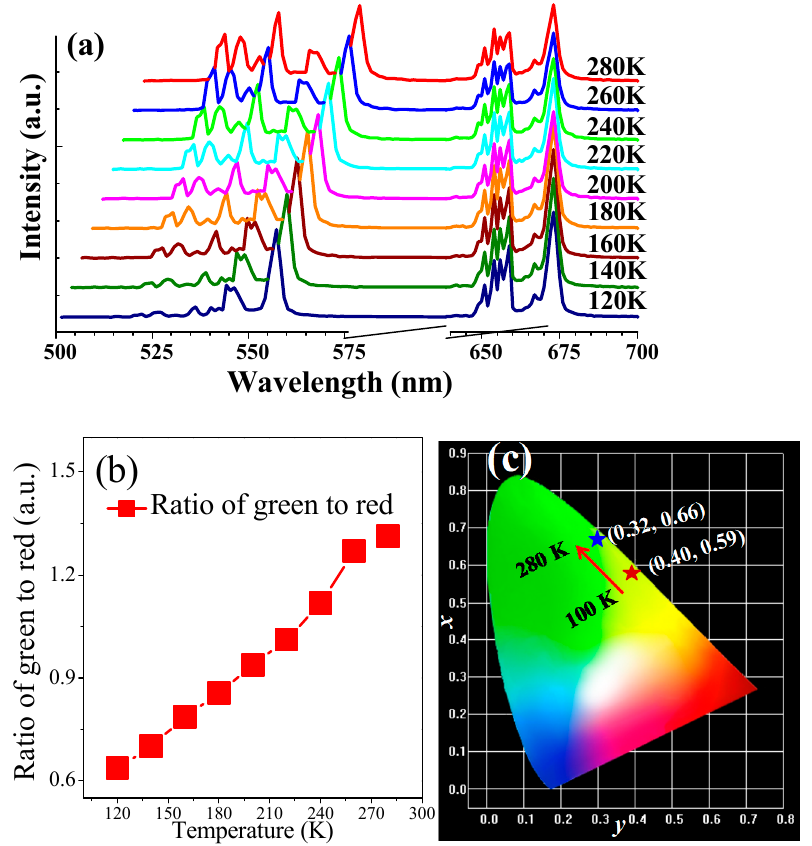
Figure 4. The temperature-dependent behaviors of YNE-1 phosphor measured from 120 to 280 K under 980 nm excitation: ( a ) temperature-dependent UC emission spectra; ( b ) intensities ratio of green to red; ( c ) the CIE chromaticity coordinates.